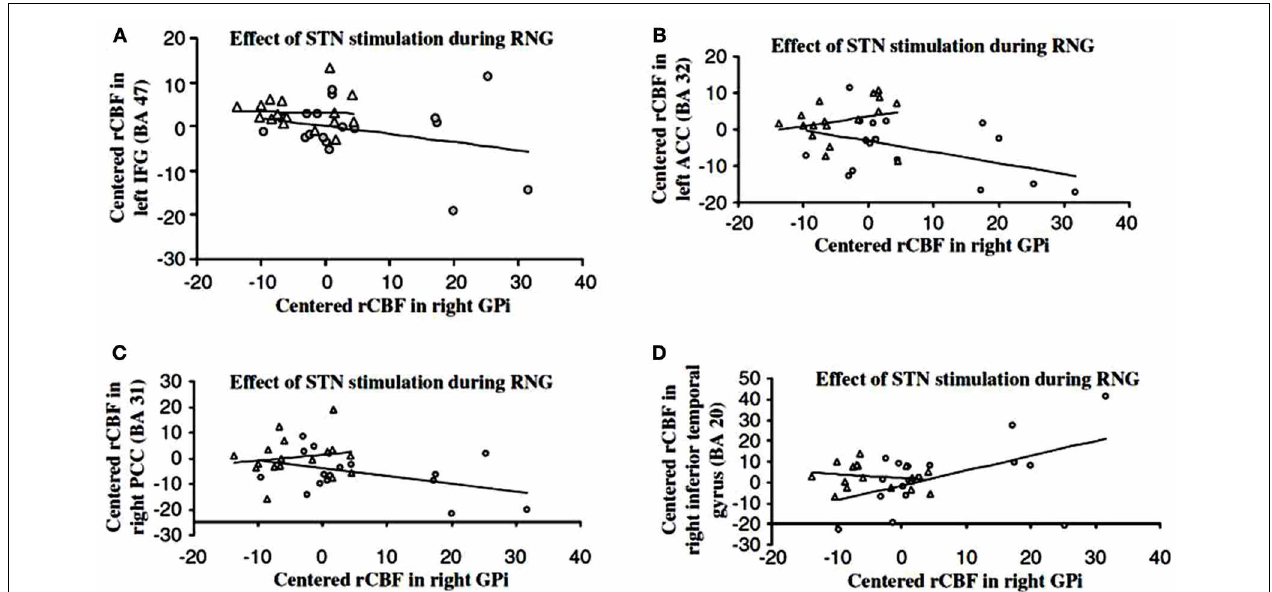
FIGURE 4 | Psychophysiological interactions showing negative coupling between the right internal segment of the globus pallidus (GPi) and the (A) inferior frontal cortex (IFC), (B) anterior cingulate cortex (ACC), (C) posterior cingulate cortex (PCC) and positive coupling between the right